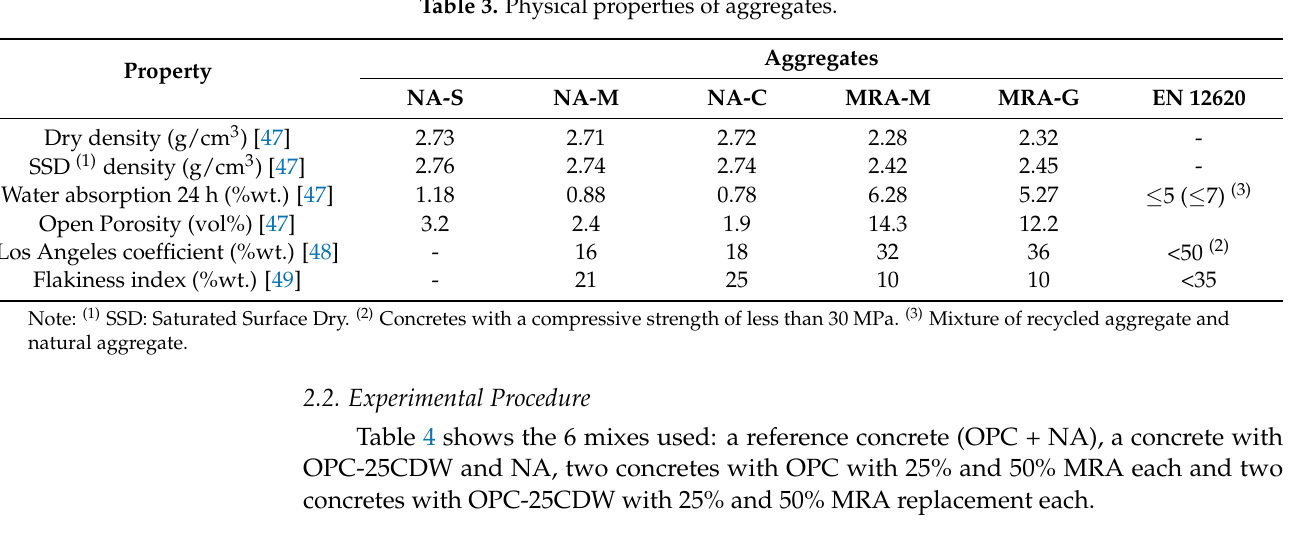
Table 4. Identification of manufactured concrete.